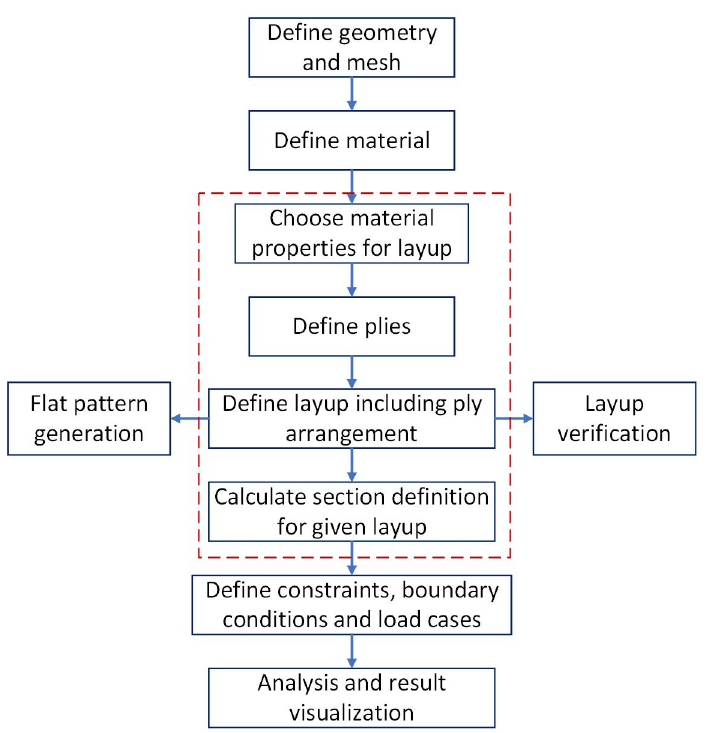
Figure 3. Modal analysis steps used in ABAQUS/CAE composite modeler.